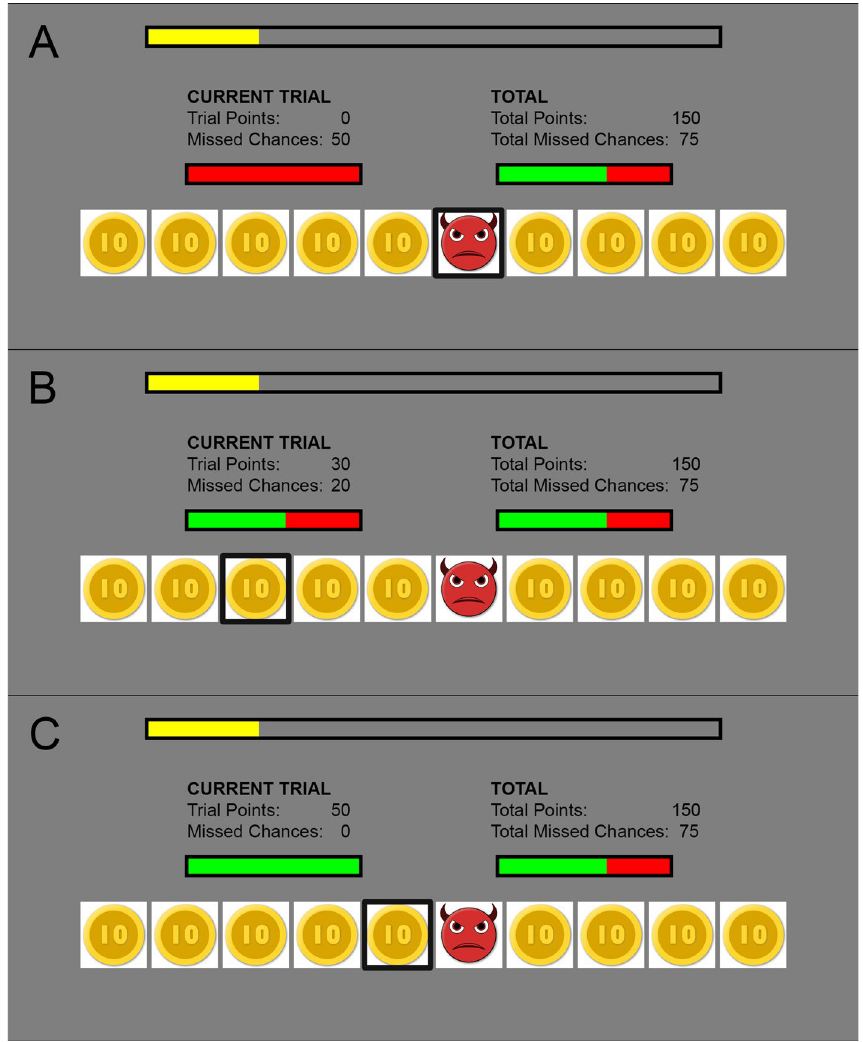
Figure 1. Choice outcome display at the end of a trial. Due to copyright restrictions, the presented stimuli depicting points and the devil slightly differ from the actual employed stimuli in the